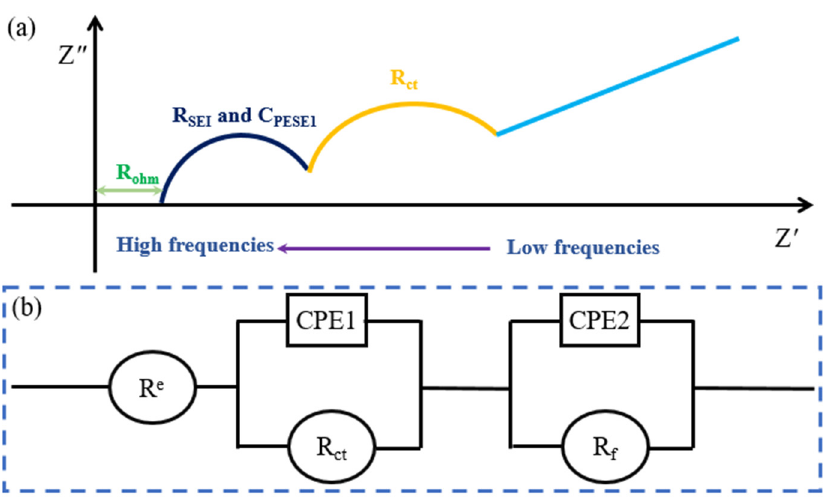
Figure 4. ( a ) Typical electrochemical impedance spectroscopy principal diagram and ( b ) Equivalent circuit model of Lithium-ion battery. circuit model of Lithium-ion